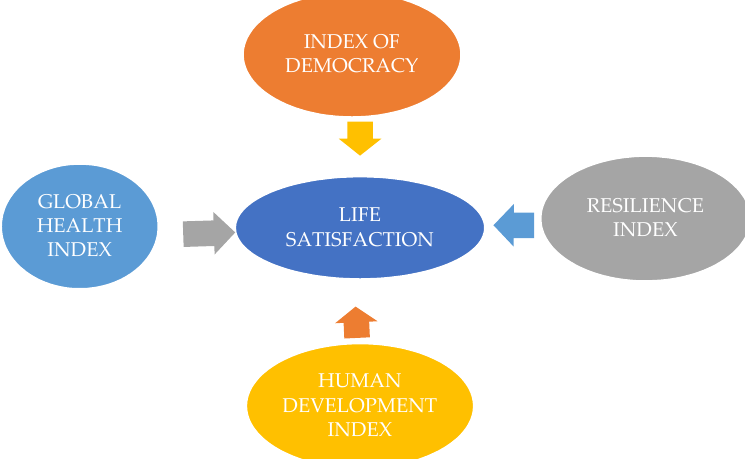
Figure 1. Correlation between research concepts.